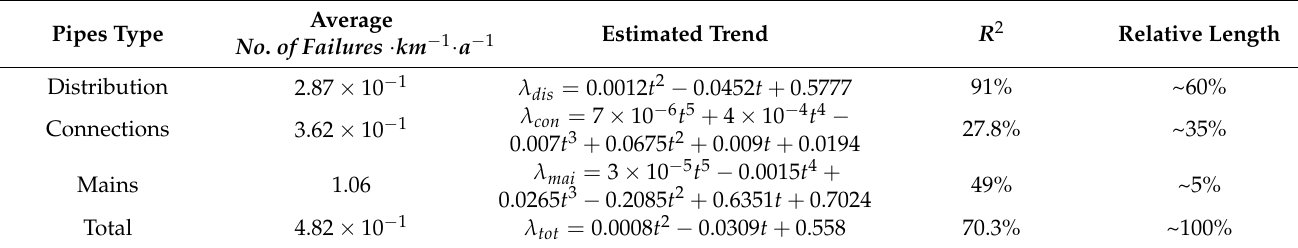
Table 1. Synthesis of the statistical analyses of the failure